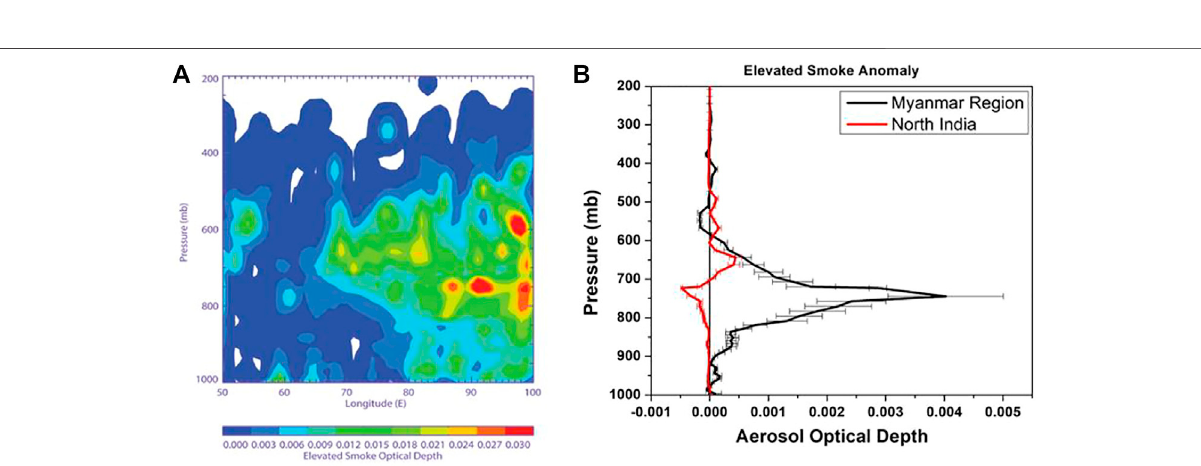
FIGURE 3 | (A) Longitudinal variation of elevated smoke aerosols from CALIPSO at 532 nm during the lockdown period. (B) Pro fi le of elevated smoke aerosol anomaly(2020-climatology)averagedforthelockdownperiodandoverforthetworegions:Myanmar(12 – 25 o Nand92 – 100 o E)andNorthIndia(22 – 30 o Nand74 – 81 o E). Horizontal lines in Figure 3B indicate standard